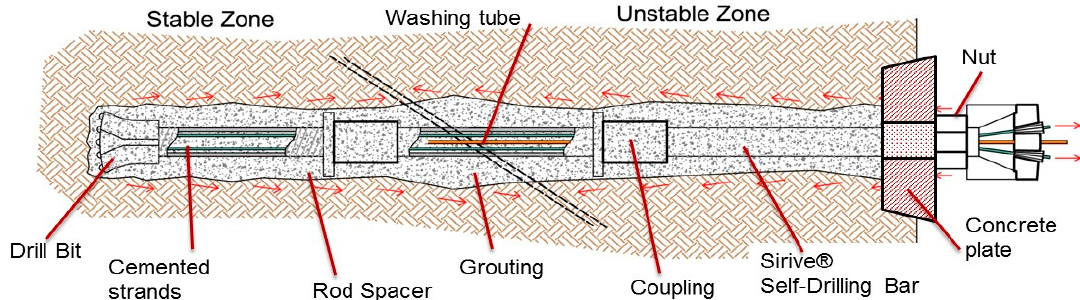
Figure 1. Elements of the composite anchors.